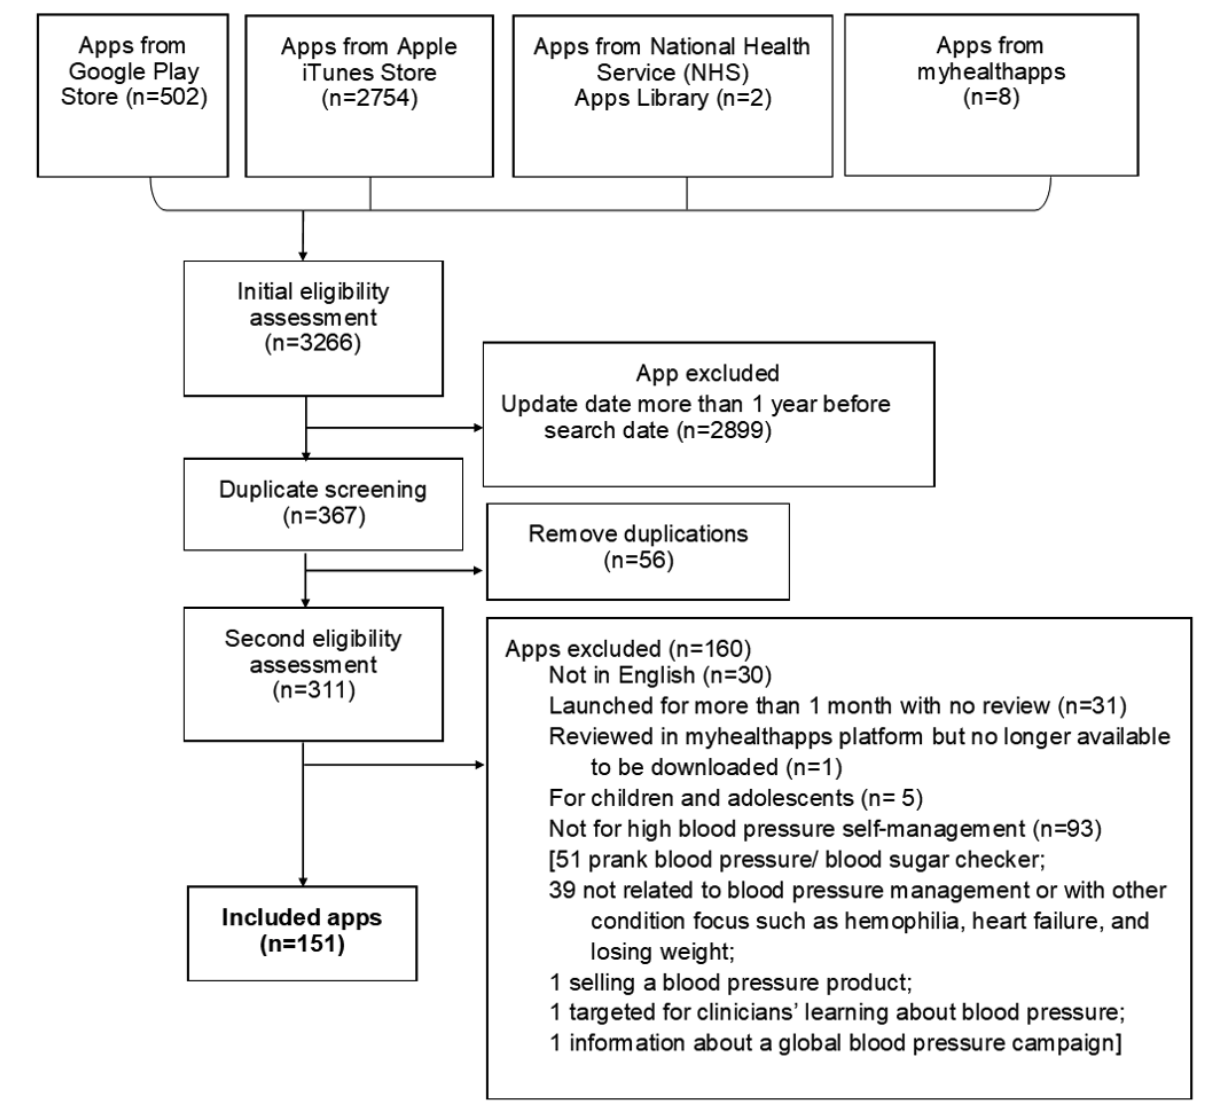
Figure 1. Flowchart of app selection and screening